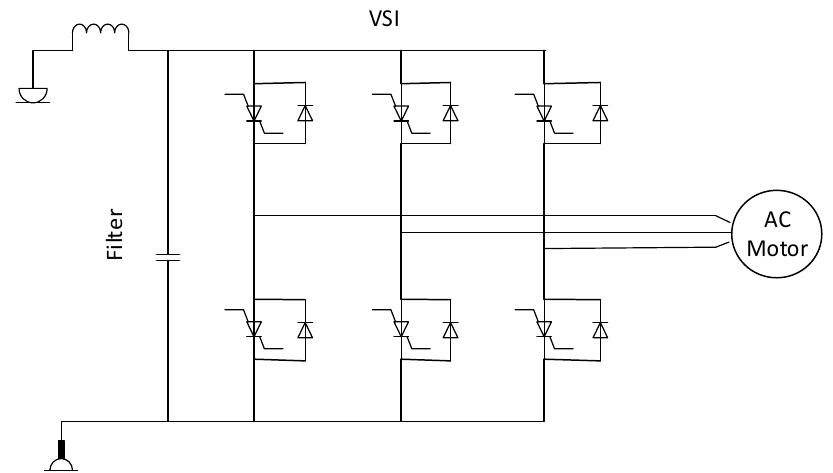
Figure 12. DC-fed VSI. Figure 12. DC-fed